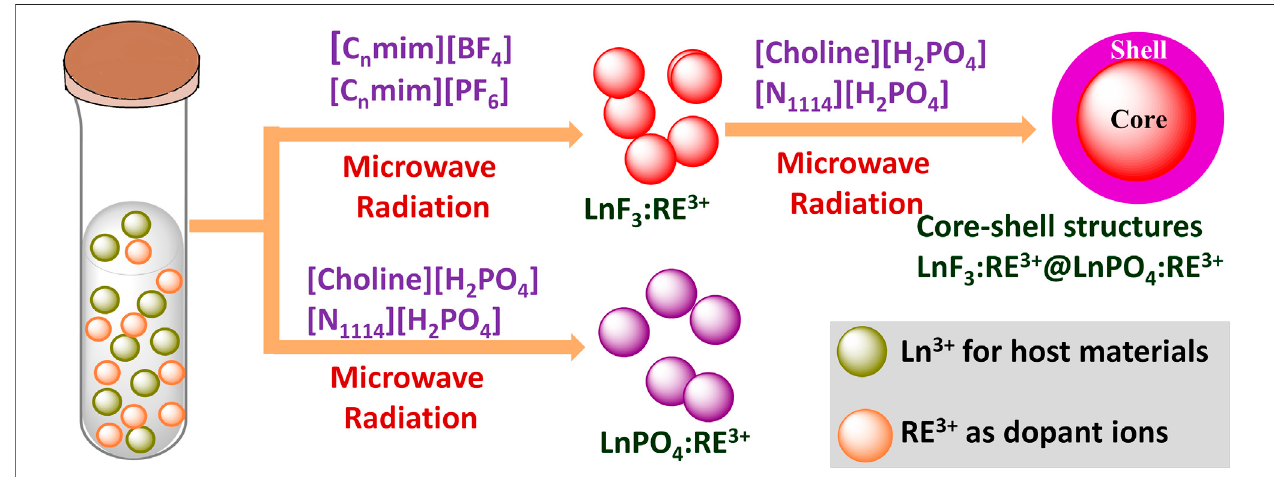
FIGURE 6 | The microwave-assited IL method for synthesis of LnF 3 :RE 3+ @LnPO 4 (Cybi ń ska et al., 2012).